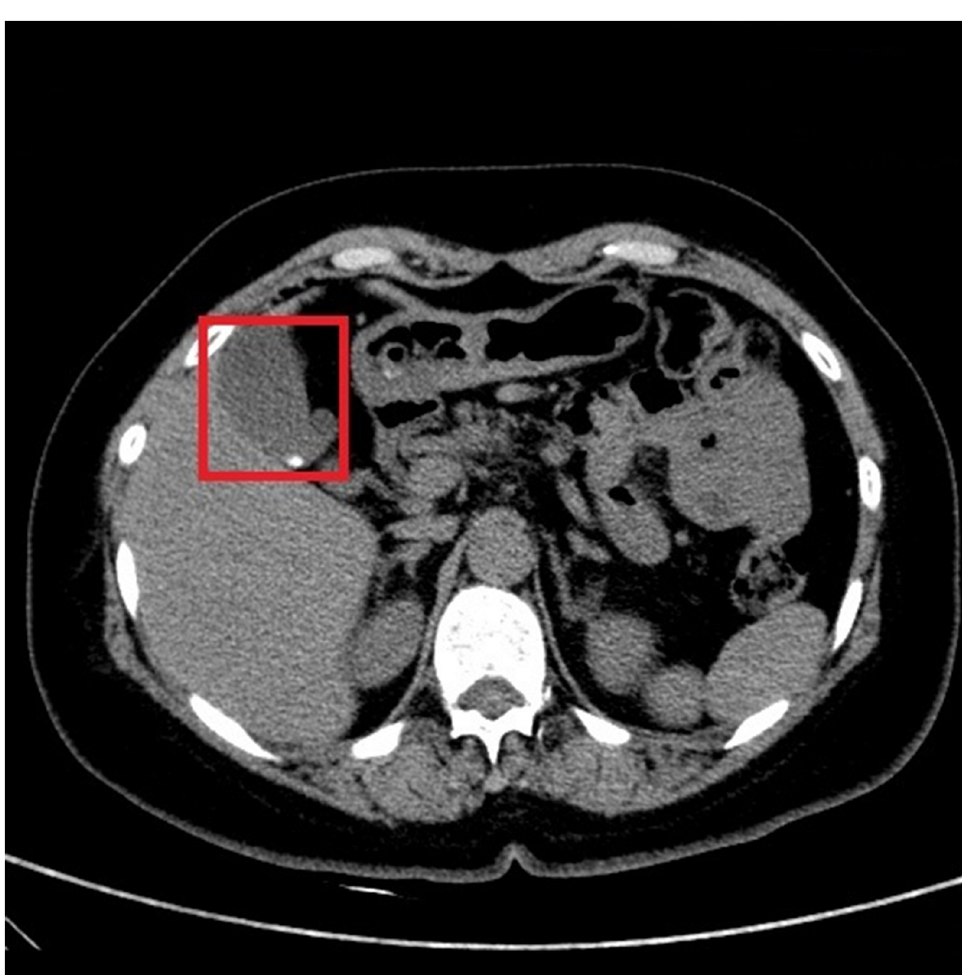
Fig 8. The CT image of a person has a lower degree of